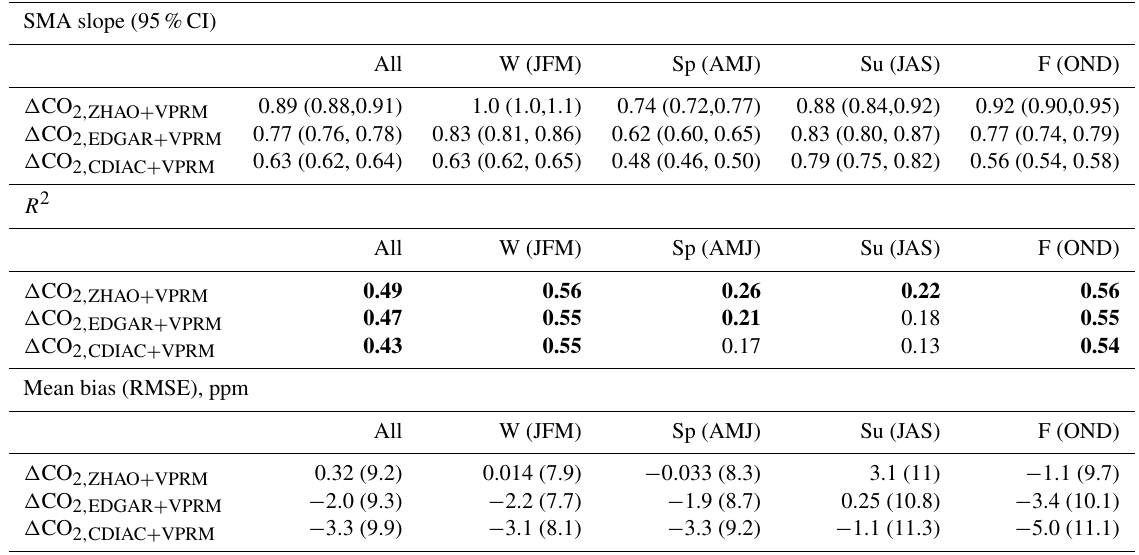
Table 1. Quantification of model–observation mismatch at hourly timescales averaged over 2005–2009 and pooled by season (W = winter; Sp = spring; Su = summer; F = fall). We provide standard major axis (SMA) slopes and 95% confidence intervals, R 2 quantities (those > 0.2 are in bold), and mean bias and root mean square error (RMSE) in